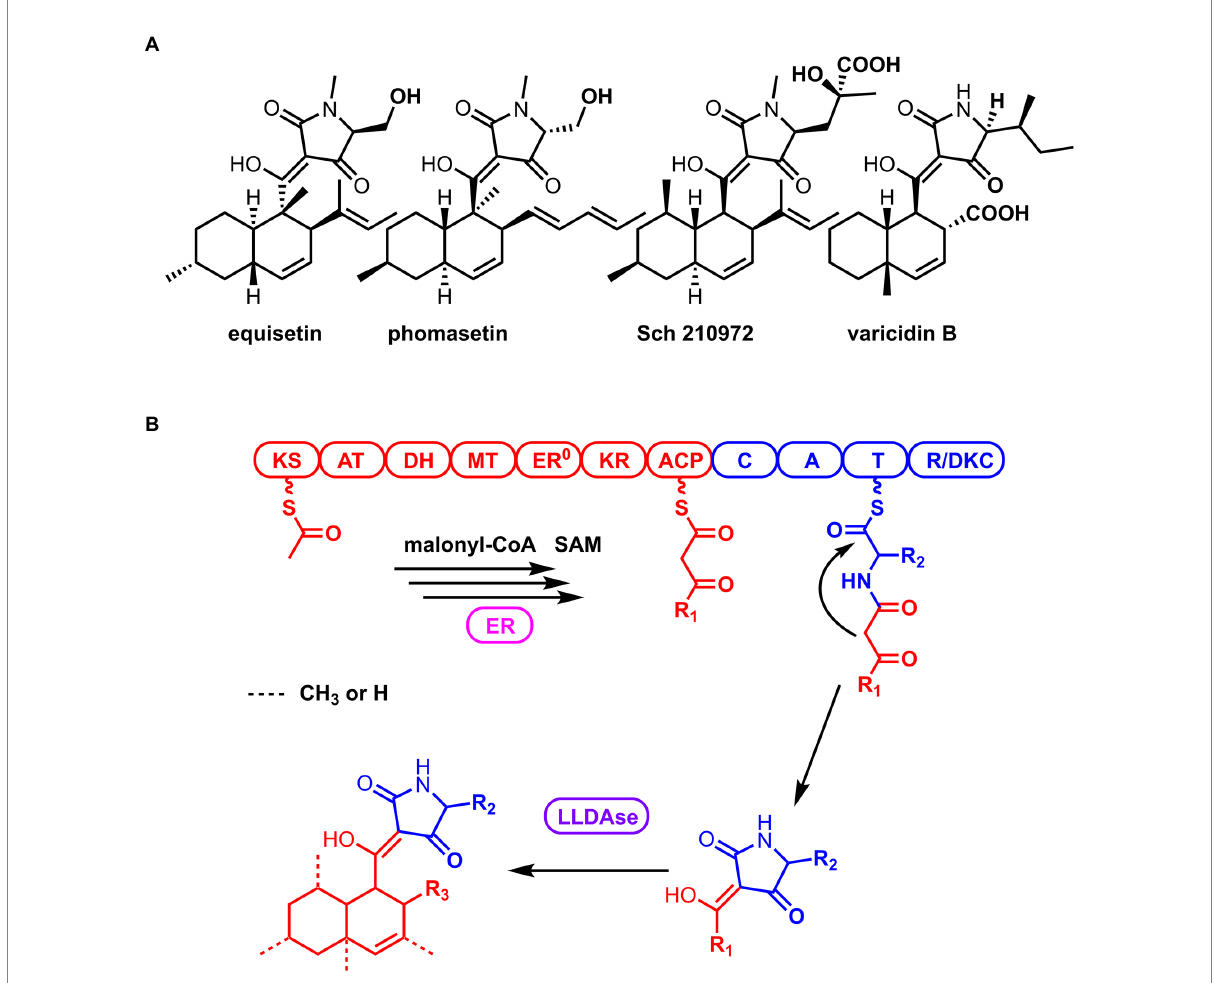
FIGURE 1 Structures of the representative 3-Decalinoyltetramic acids (DTAs; A ) and the general biosynthetic route of DTAs in fungi (B)